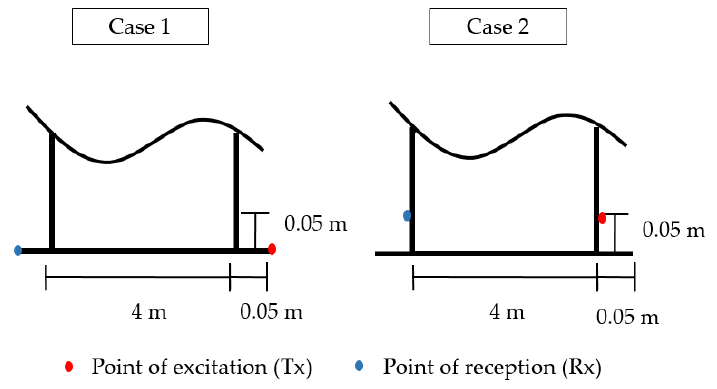
Figure 3. Layout of the Finite Element Analysis (FEA) model and the point of excitation and reception of both the cases studied. Case 1 : excitation and reception from the tank floor; and Case 2 : excitation and reception from the tank wall.